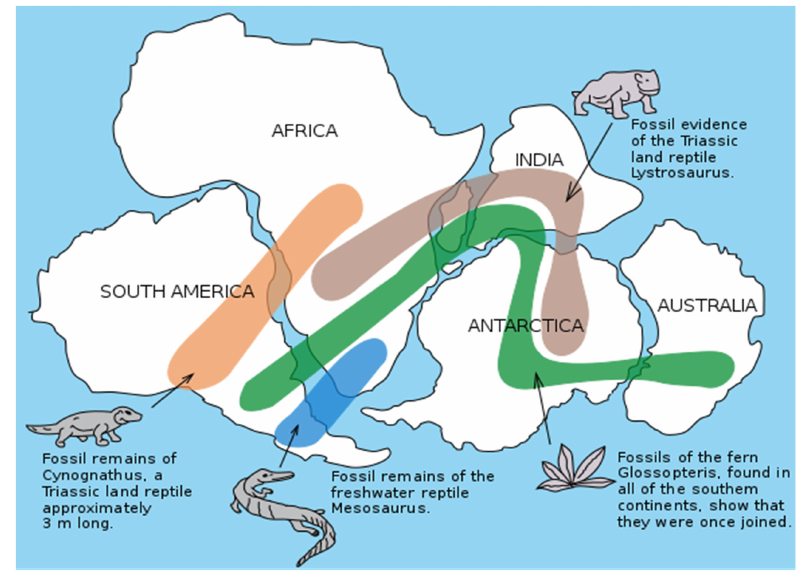
Figure 11. Connecting the dots: schematic describing the fossil patterns across continents that were the basis upon which Alfred Wegener proposed his continental drift theory: https://en.wikipedia.org/wiki/Alfred_Wegener (accessed on 28 October